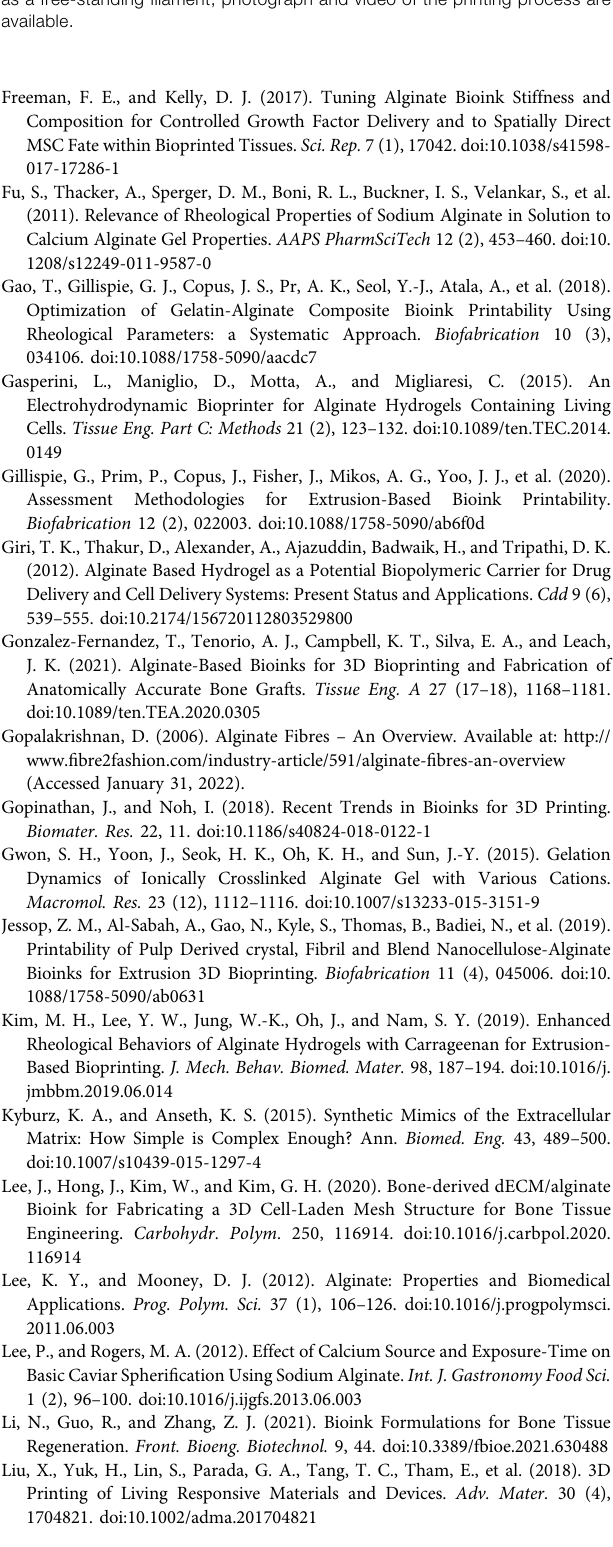
SupplementaryFigureS2| Videoofthe3Dbio-printingprocessofthelattice.This video was taken to further illustrate the 3D bio-printing process to produce a lattice using CaSO4 pre-crosslinked MVM alginate bio-ink.